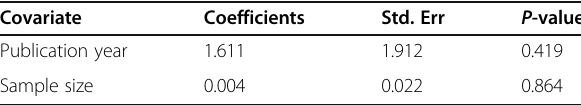
Table 2 Meta-regression analysis of factors that have influence between study